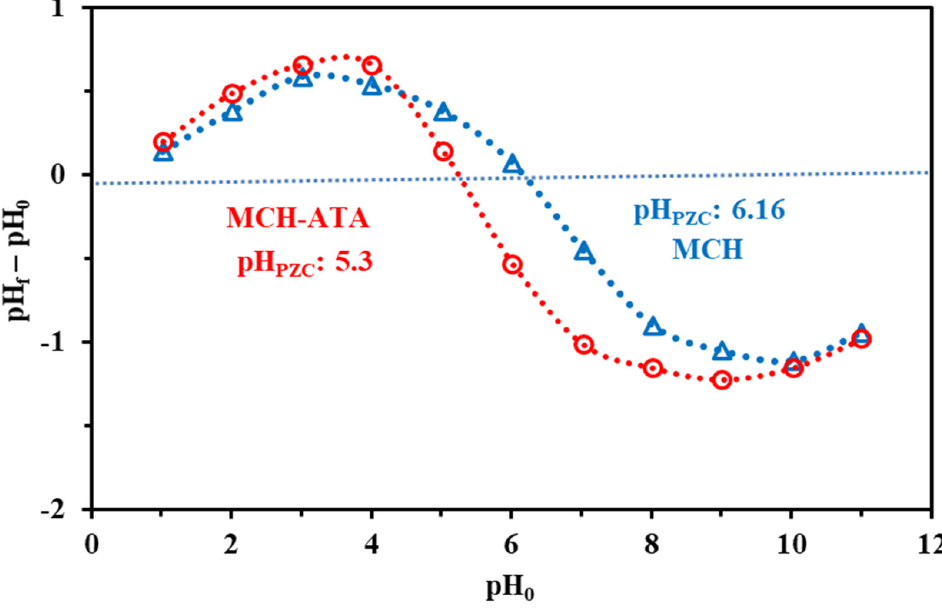
Figure 4. The variation of pH pzc of the MCc and MCa-ATA sorbents